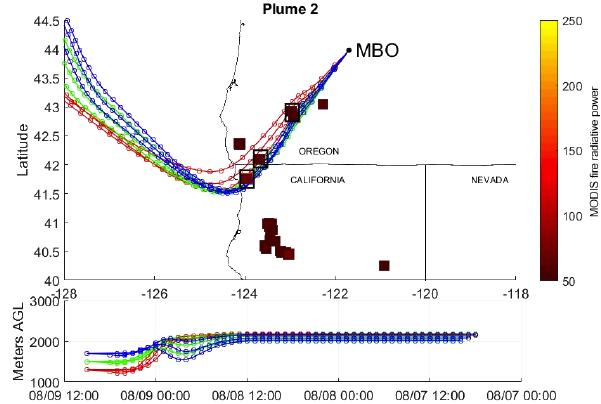
Figure 11. Back trajectories from plume 2 observed at MBO. The colored squares represent fires during the time of the back trajectory and are colored by fire radiative power. The black squares indicate the fire areas used in the parameterization to estimate D pm and σ